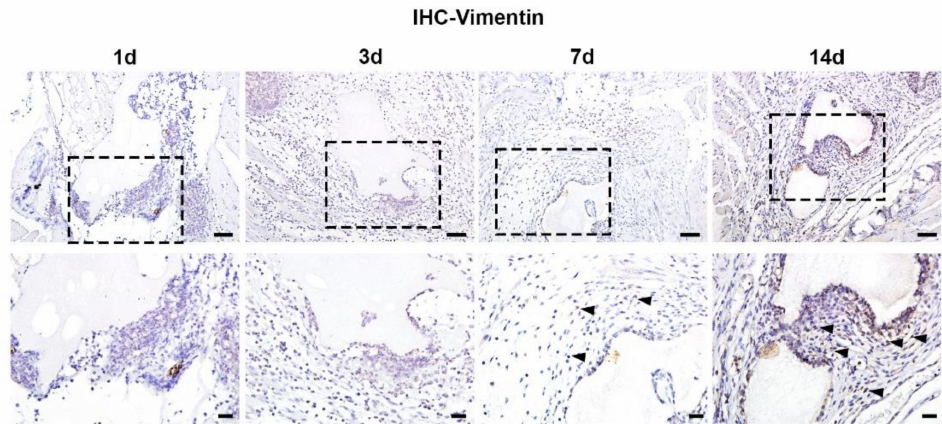
Figure 5. Temporal and spatial distribution of fibroblasts around BCP. Consecutive immunohisto- chemical staining of BCP after implantation in muscle showed the number of fibroblasts labelled by vimentin increased dramatically during 14-day implantation as indicated by black triangles in magnified images. Scale bar: 50 µ m and 20 µ m,